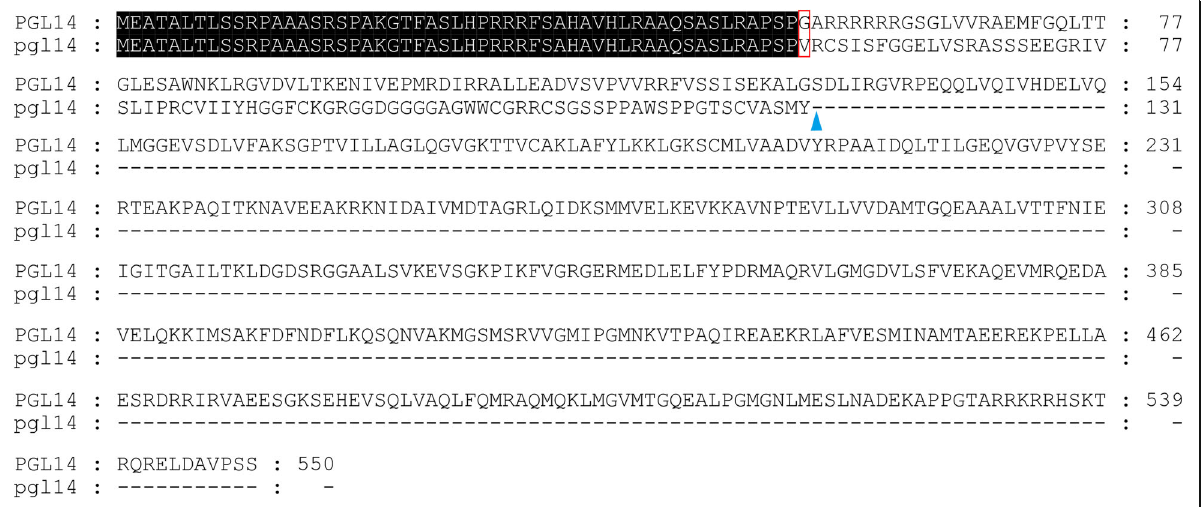
Fig. 2 Alignment of the amino acid sequences of LOC_Os11g05552 in WT and pgl14. pgl14 is the predicted amino acid sequence deduced from abnormal transcript detected in pgl14. Frame shift in pgl14 is indicated by the red box. Blue arrow indicates the premature termination in